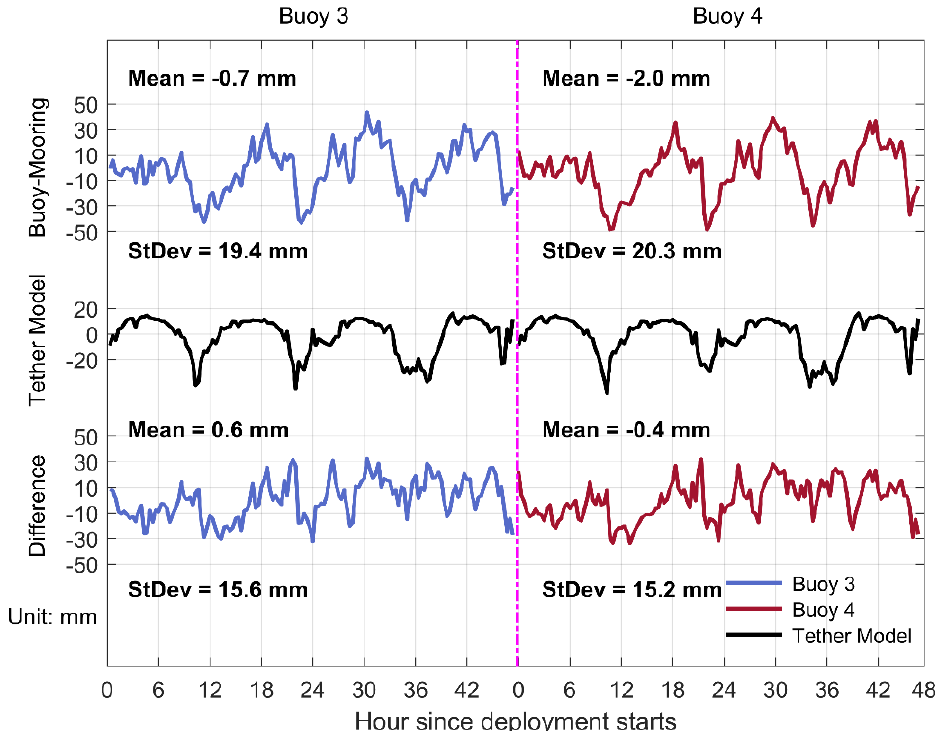
Figure 4. Residual investigation for the August 2015 deployment; Upper section: SSH residual between buoy and mooring; Middle section: simulated signal as a function of current and wind stress; Lower section: difference between tether modelled SSH residual and measured SSH residual; StDev stands for standard deviation; Vertical line is to separate Buoy 3 and Buoy 4 solutions in the same deployment.